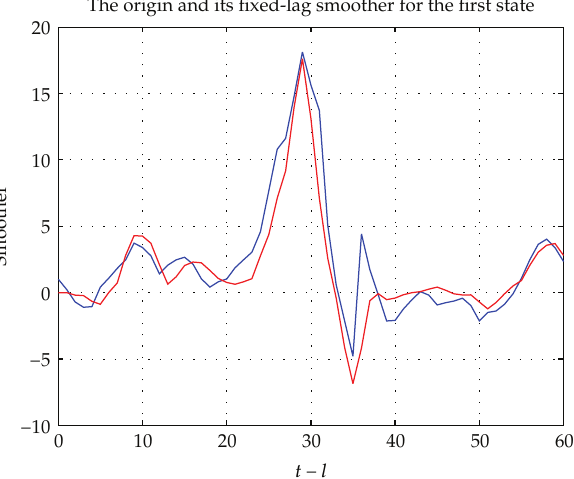
Figure 5: The origin and its fixed-lag smoother (cid:13) x 1 (cid:2) t − l | t (cid:3) , where the blue line is the origin signal, the red line is the